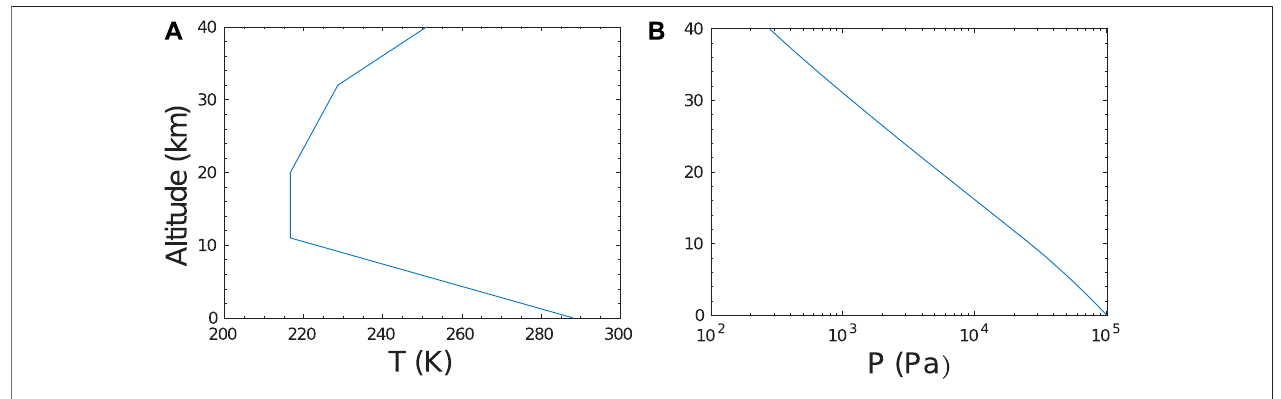
FIGURE 1 | Vertical distribution of the meteorological parameters in SATP: (A) temperature T, and (B) pressure P.